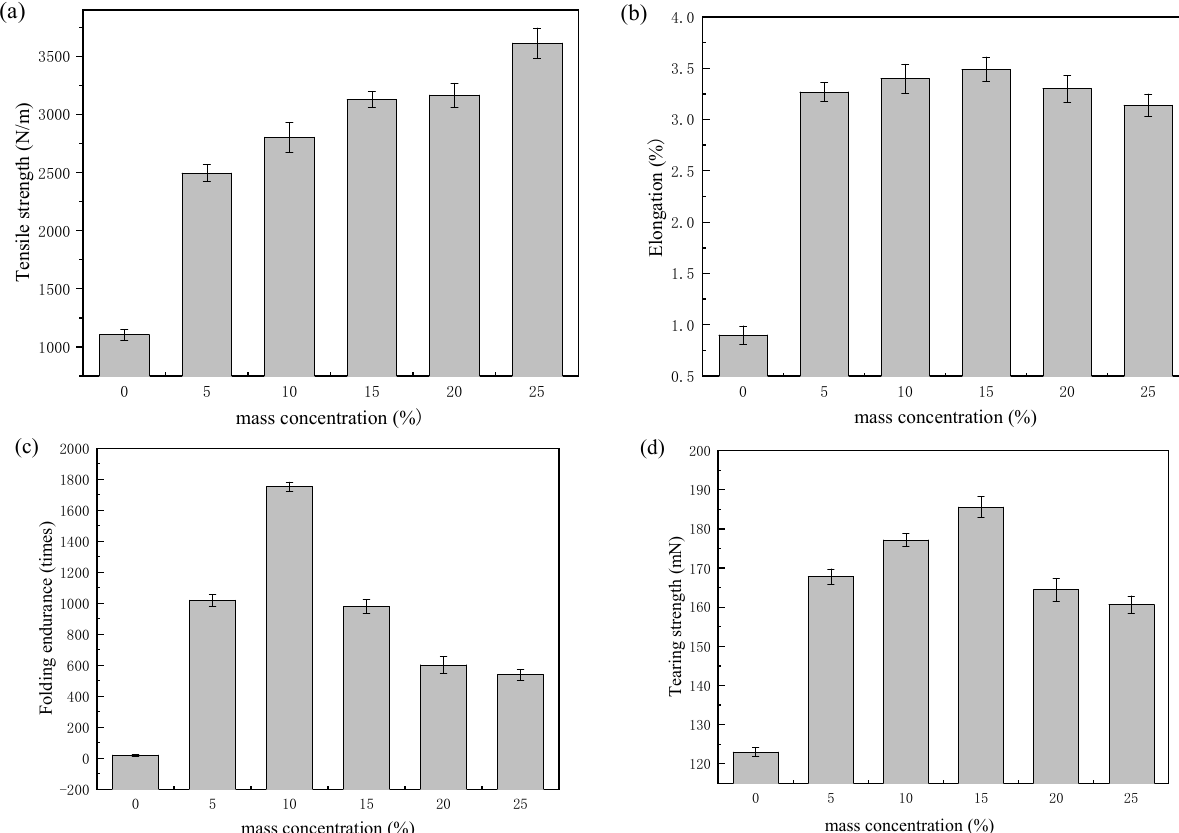
Figure 6. Mechanical properties of the paper treated with different mass concentrations of polyurethane: ( a ) tensile strength; ( b ) elongation; ( c ) folding endurance; ( d ) tearing strength.